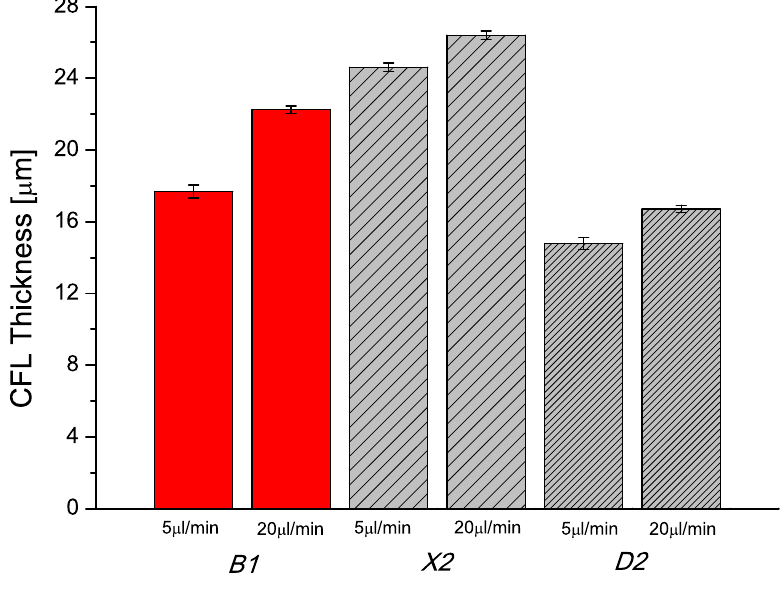
Figure 7. Comparison of mean CFL thickness in downstream region between the fluid B1 , RBCs suspended in Dx40; X2 , particulate-viscoelastic fluid and D2 , PMMA particles in Dx40, as a function of flow rate, 5 µL/min and 20 µL/min. The error bar means 95% confidence